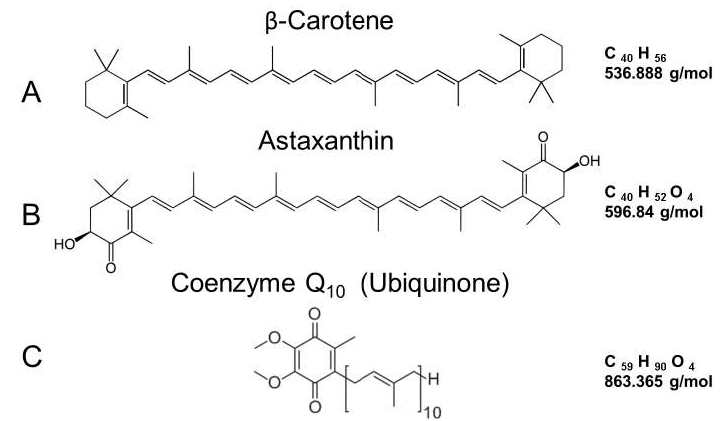
Figure 3. ( A ) The chemical structure and chemical characteristics of β -carotene. β -carotene is a carotenoid found in many naturally occurring fat-soluble yellow, orange, red, and green leafy pigments synthesized in fruits and vegetable [62–64]. ( B ) The chemical structure and chemical characteristics of astaxanthin. It is a keto-carotenoid, which is similar in chemical structure to β -carotene and it is found in plants, animals, and algae [67–69]. ( C ) The chemical structure and chemical characteristics of coenzyme Q 10 . It is a novel quinone in the lipid extracts of mitochondria and participates in the electron transport chain [70,71].